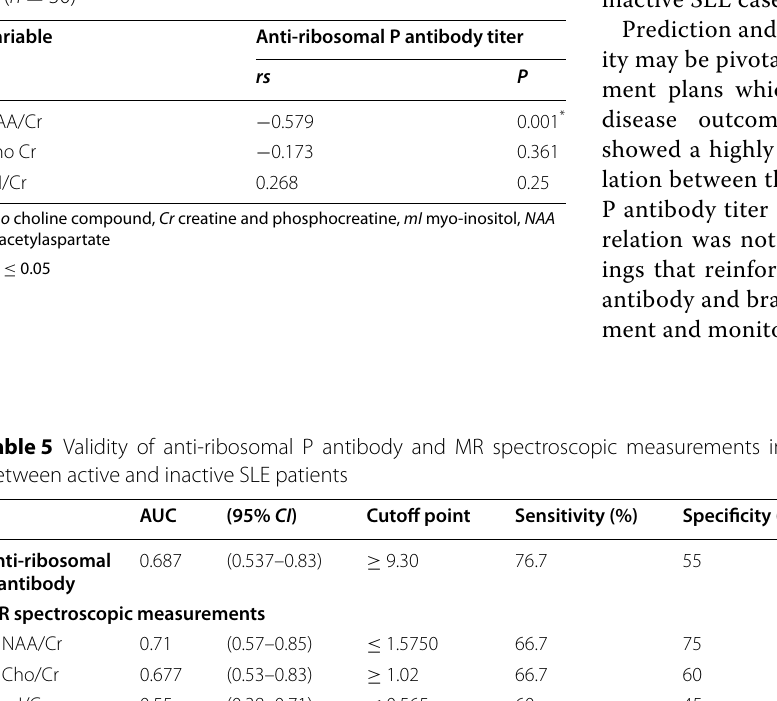
AUC area under the curve, Cho choline compound, Cr creatine and phosphocreatine, mI myo-inositol, NAA